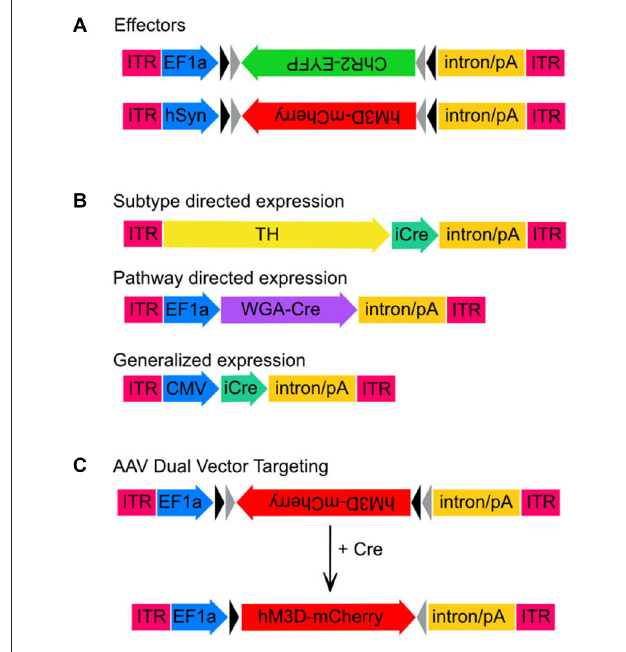
FIGURE 1 | Adeno-associated virus (AAV) transgenes used in this study. Schematic maps of AAV vector constructs. (A) Effector gene constructs, ChR2 and hM3Dq and the promoters used to drive high neuronal expression rates, EF1- α and hSyn, respectively. Note that both effector molecule sequences are in the DIO position. (B) Maps of the three vector constructs used to drive expression of Cre-recombinase. Sizes are approximate and demonstrate that the TH promoter is much larger than either EF1- α or CMV. (C) Unlocking of the hM3Dq construct from the DIO orientation to the sense orientation following Cre-mediated